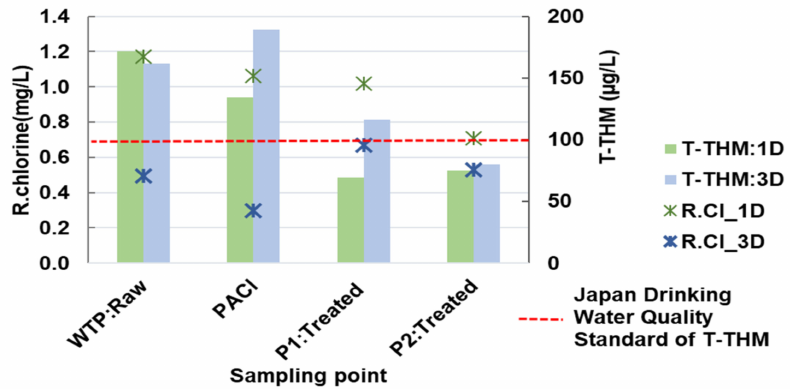
Figure 10. THMFP of the samples in N-WTP. Note: R.Cl, residual chlorine; 1D, one day; 3D, three